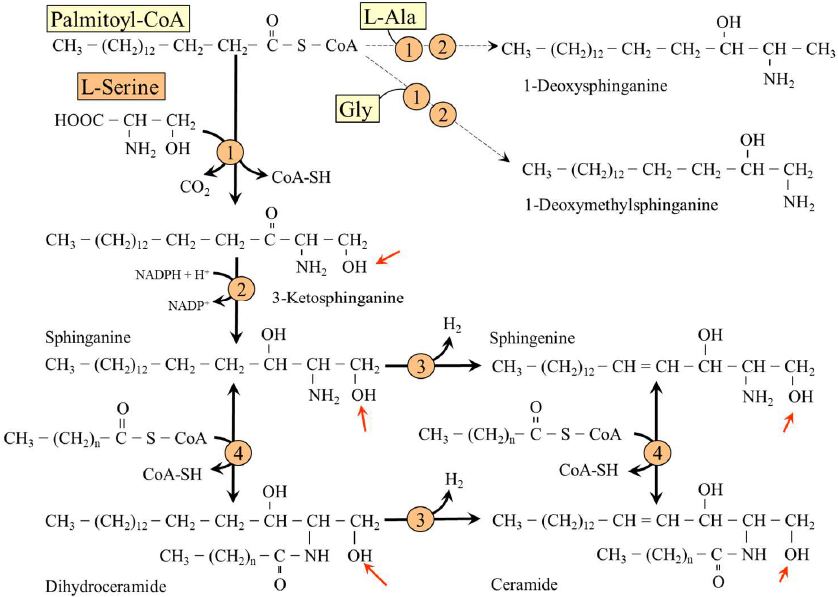
Figure 7. Synthesis of sphingosines, ceramides and deoxysphingosines. 1, Serine palmitoyltransferase; 2, ketosphinganinereductase; 3, dehydrogenase; 4, ceramidesynthase. Arrows indicate a hydroxyl group used for the synthesis of various types of SL that is missing in DSL.